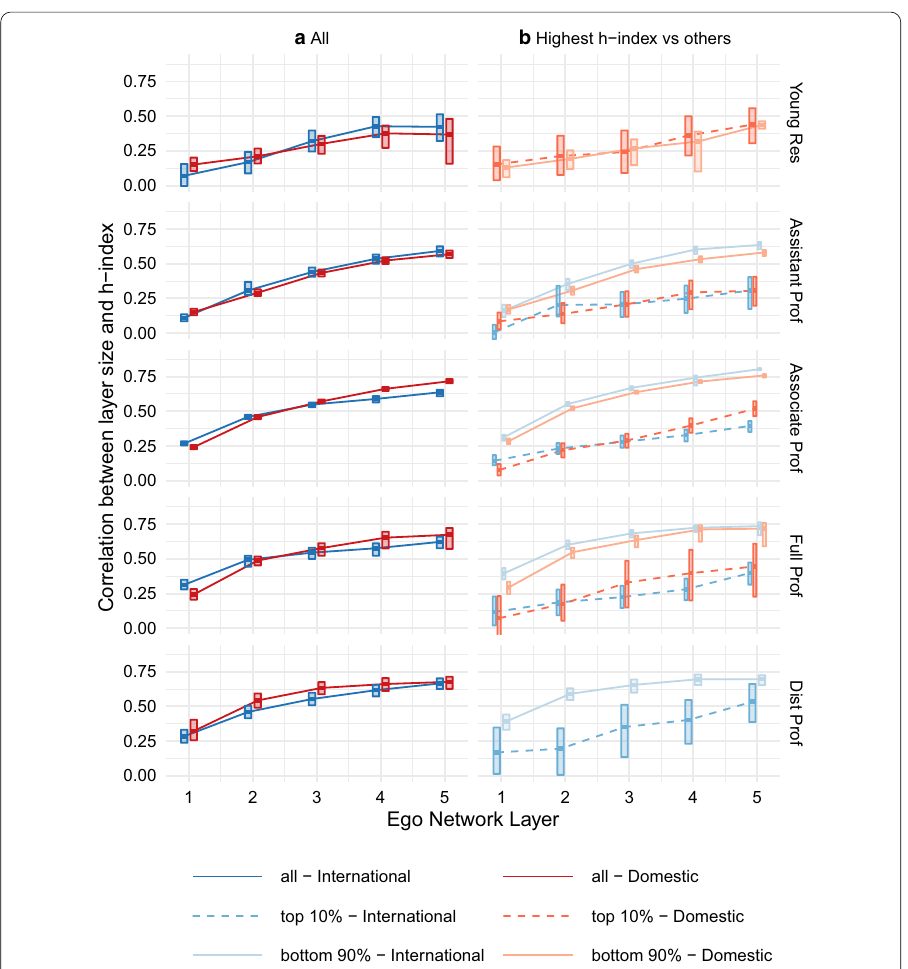
Fig. 11 Impact and co-authorship ego networks for international (blue) and domestic (red) migrants. Correlation between ego network layer size and the h-index. Dashed lines are used for the group of researchers with the highest